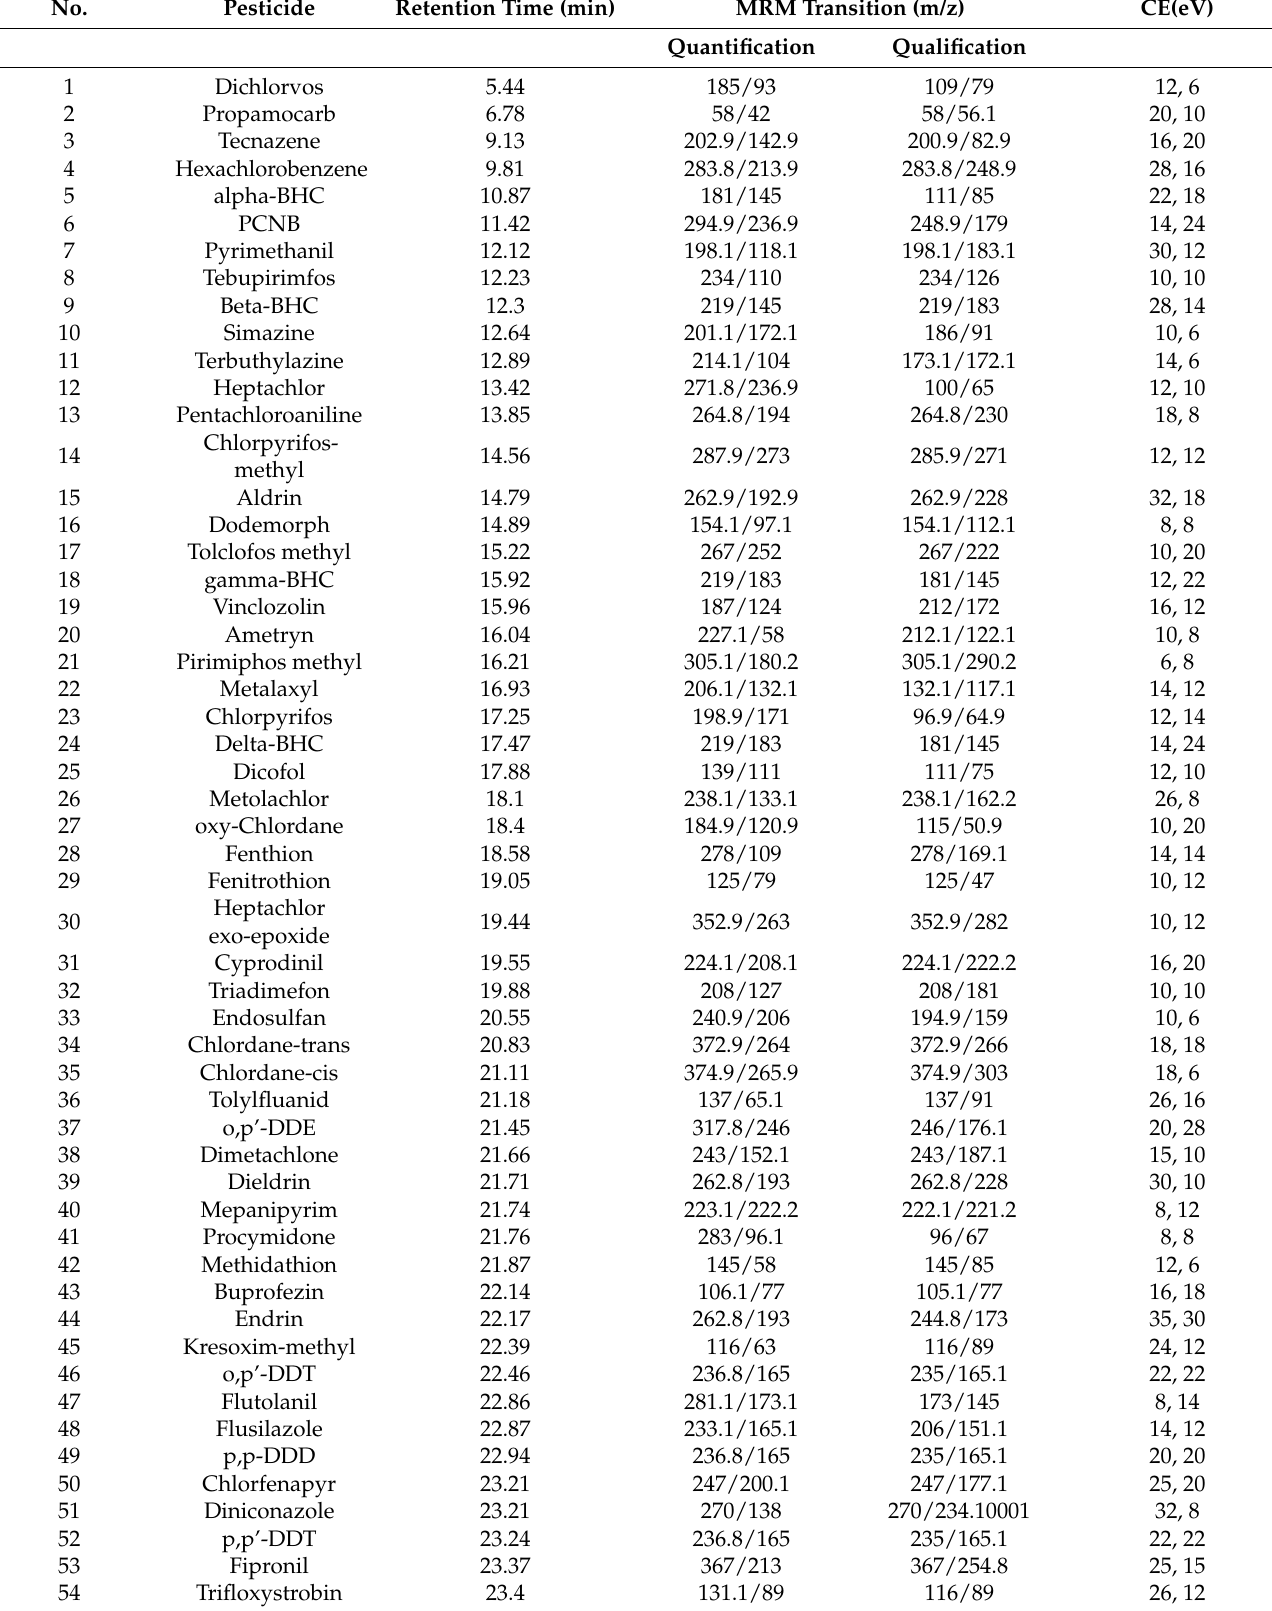
Table 1. The retention time, MRM transitions for each